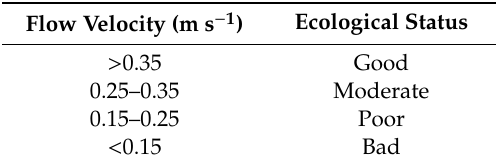
Table 3. Assessment classes according to flow velocities: overall assessment (modified after Reference [32]).